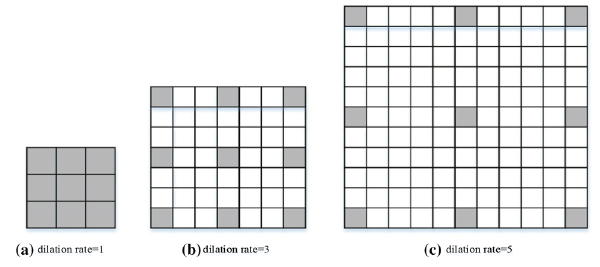
Fig. 1 Atrous convolution with different dilation